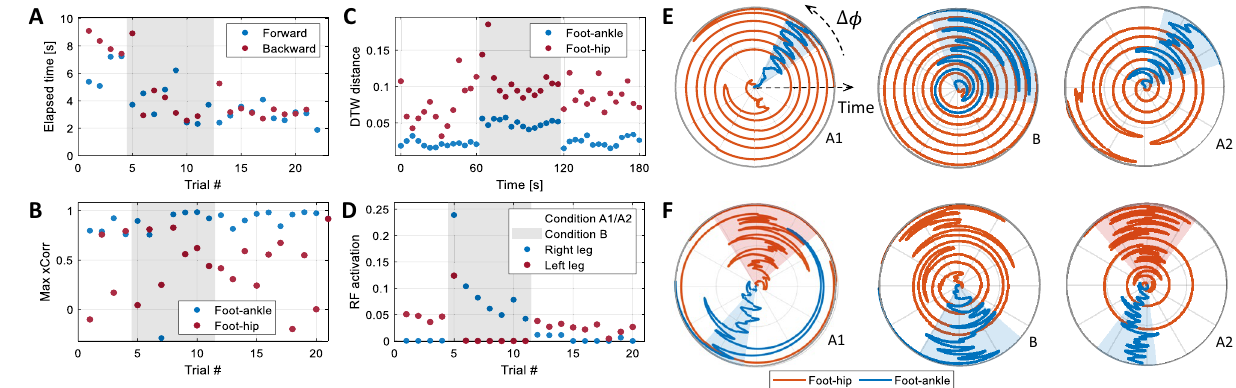
Figure 4. Results of a representative participant (#9): ( A ) Trial elapsed time in forward and backward motion; ( B ) Maximum cross-correlation between the foot, and the ankle and hip angles for the right leg in each trial; ( C ) DTW distance between the right foot angle, and the ankle and hip angles; ( D ) Rectus Femoris activation in backward movement in each trial for the right leg; ( E ) The instantaneous phase difference ( �φ ) between the right foot profile, and the right ankle and hip angles for A1, B, and A2 conditions. The distance from the origin represents the sample time while the angle represents the phase difference ( �φ ). In all conditions, �φ hip travels the whole phase circle several times. The �φ ankle . ( F ) Phase analysis for the expert participant who tried to control the hoverboard mostly with the hip. The ankle phase is still bounded in all conditions similar to the ankle strategy. The hip phase is also bounded in conditions A1 and A2 and has fewer variations even in condition B as a result of adopting hip or a multi-joint strategy.